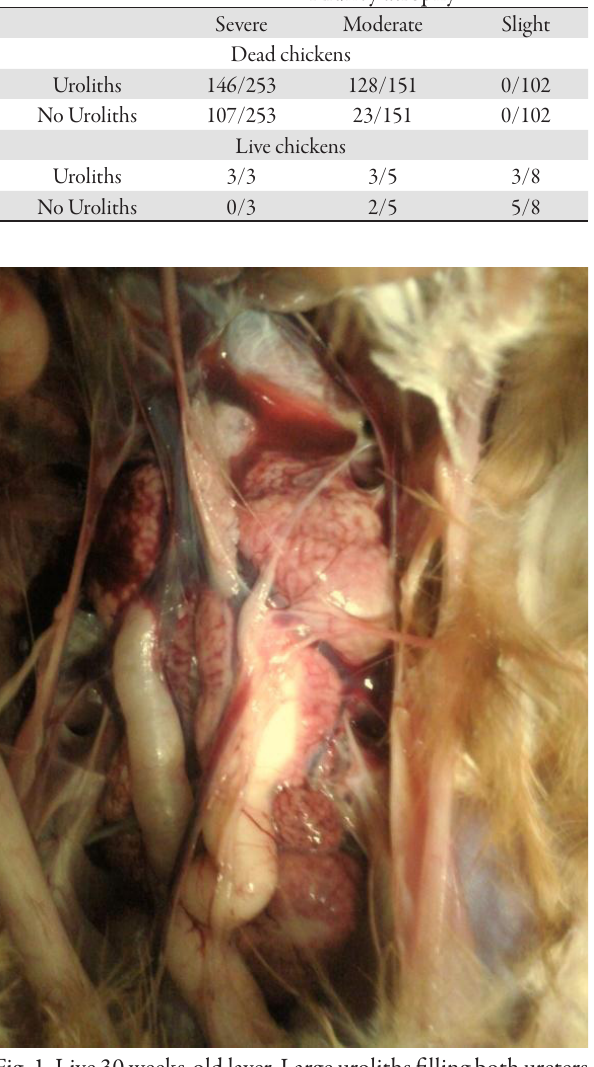
Fig. 1. Live 30 weeks-old layer. Large uroliths filling both ureters with moderate atrophy of the right kidney